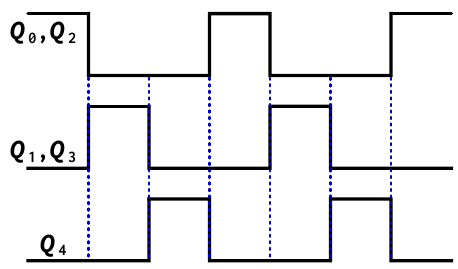
Figure 4. Switching sequences of the proposed equalizer at V B 0 > V B 1 .